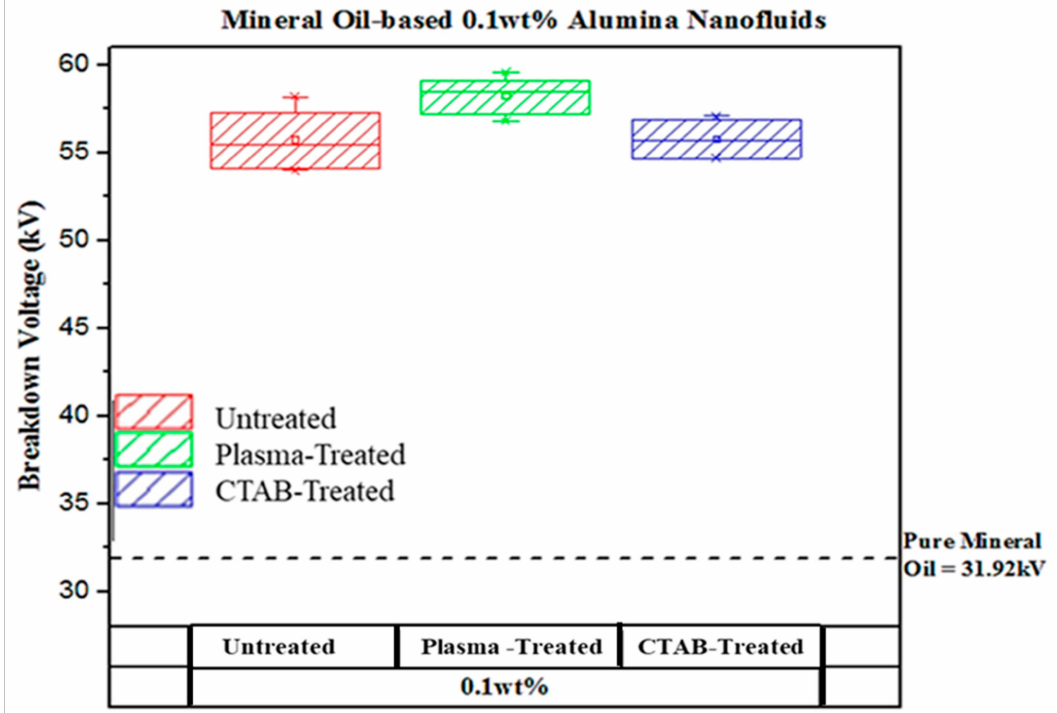
Figure 5. Average AC breakdown voltages of mineral oil-based with 0.1 wt% of plasma-treated, untreated, and CTAB-treated alumina